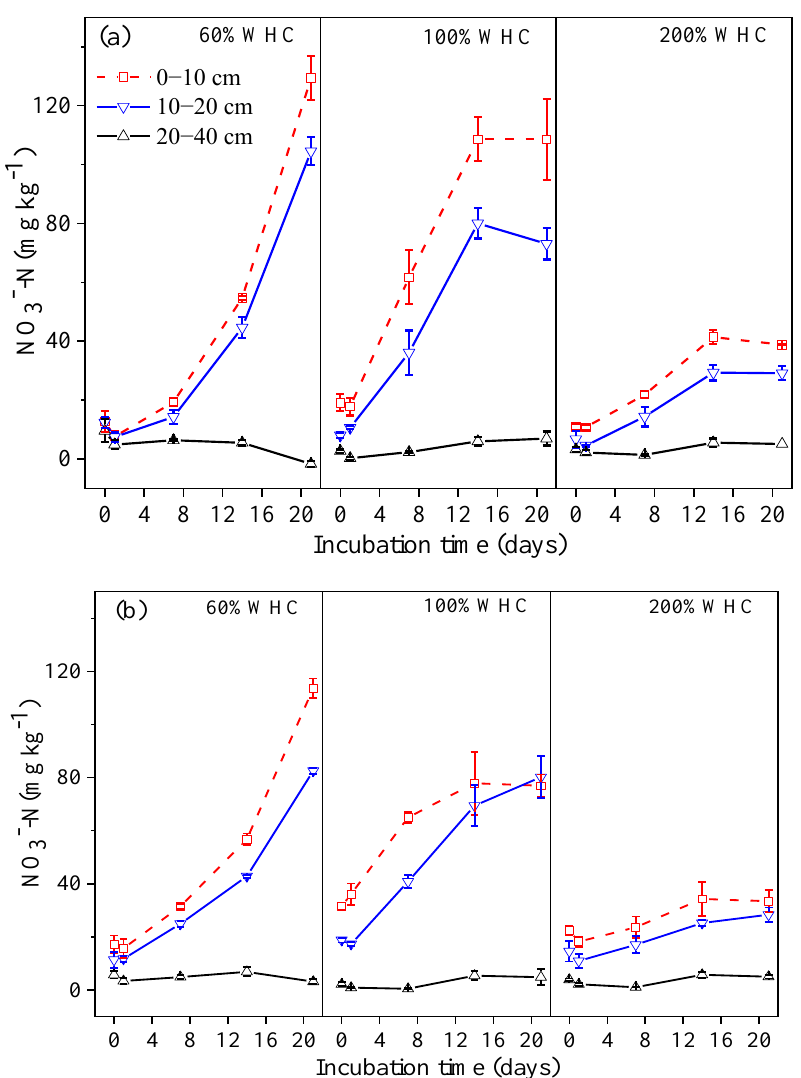
Figure 3. The dynamic changes of NO 3 − -N contents in hydromorphic ( a ) and gleyed ( b ) paddy soils at three soil moisture levels during 21-day incubation. The values represent the mean of three replicates, and the error bars represent standard errors.